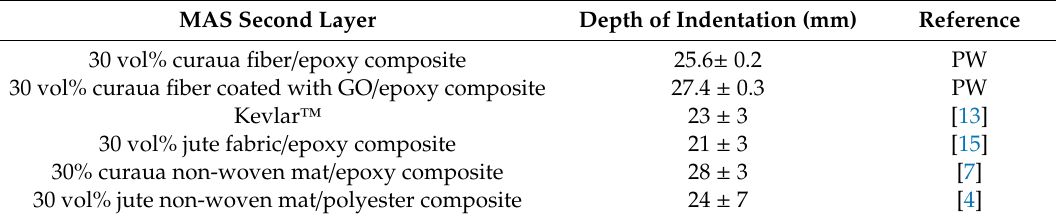
Table 2. Depth of indentation of MAS with natural fibers composites and same thickness Kevlar ™ for